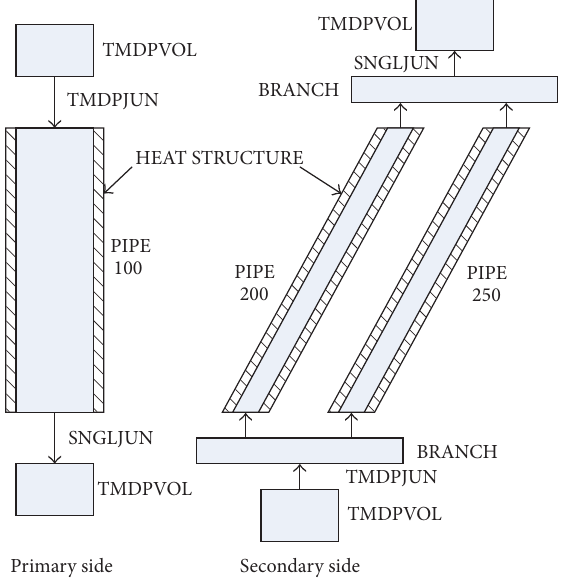
Figure 7: Comparisons between STFQH and RELAP5 regarding heated region pressure drops and threshold inlet throttling to stabilize the